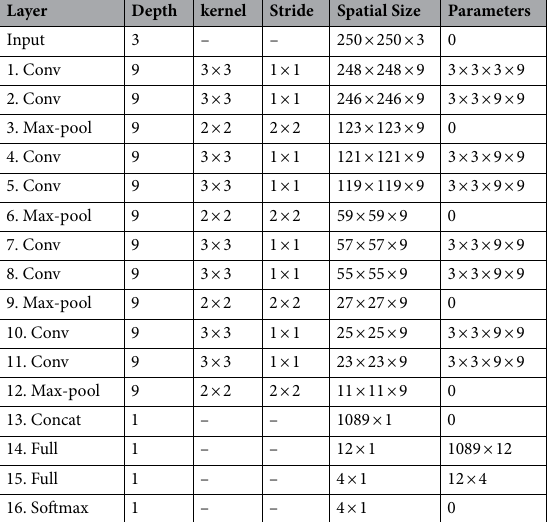
Table 1. The proposed CNN configuration for an input patch of size 250 × 250. Total number of parameters =